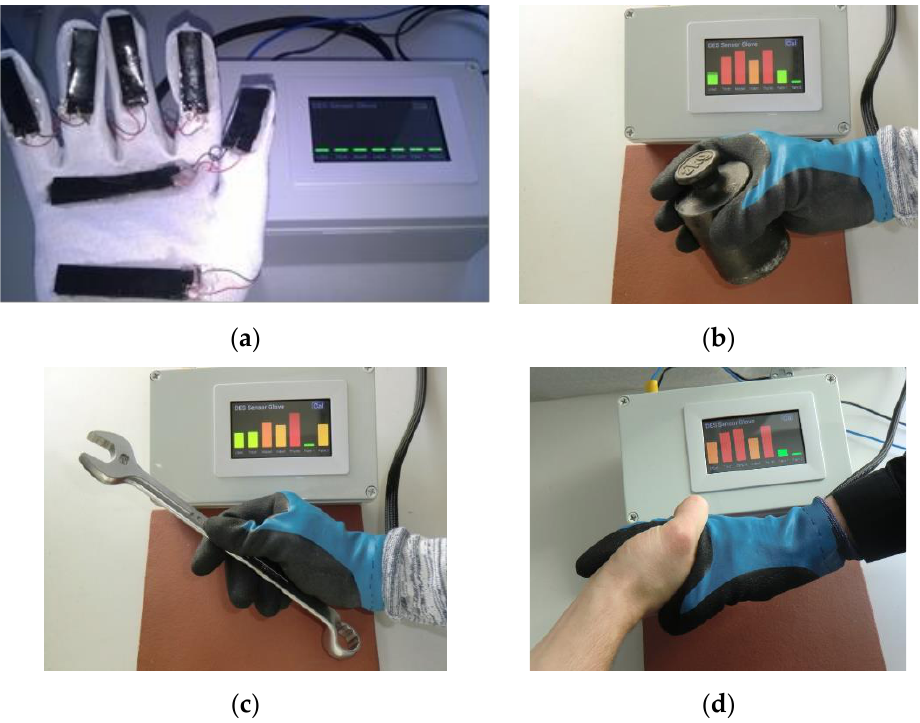
Figure 20. Glove equipped with seven pressure sensors on the fingers and on the palm ( a ) and sensor signals for different hand operations: grabbing a cylindrical weight ( b ), grabbing a screw wrench ( c ) and handshaking ( d ) [100].